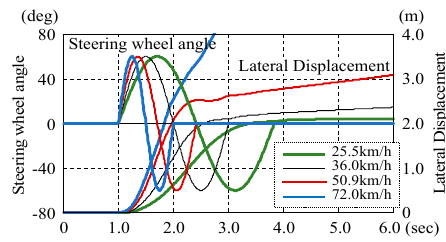
Figure 11. Required steering input angle (I = 50).